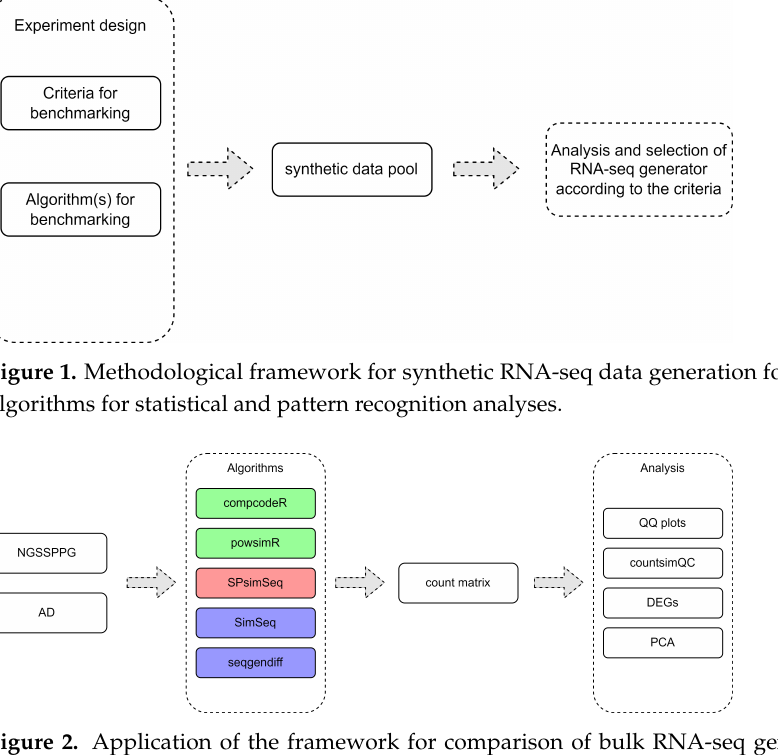
Figure 2. Application of the framework for comparison of bulk RNA-seq generators. Different colors indicate different types of methods. compcodeR and powsimR are parametric, SPsimSeq is semiparametric, and SimSeq and seqgendiff are